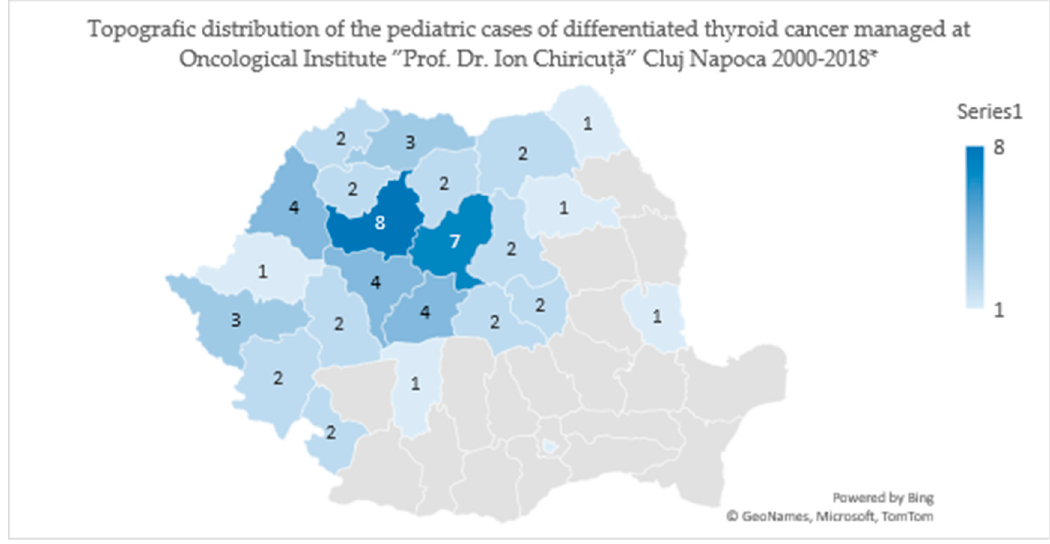
Figure 1. Topographic distribution of thyroid cancer cases in children treated at the Oncological Institute “Prof. Dr. Ion Chiricu ță ” Cluj-Napoca (IOCN) from 2000–2018. * The case from Bucharest comes, in fact, from the Republic of Moldova; the patient was diagnosed in a medical center in Chisinau. There the therapy was initiated, and later the family decided to move to Romania, with an official address in Bucharest, and went to IOCN to continue specific treatment.